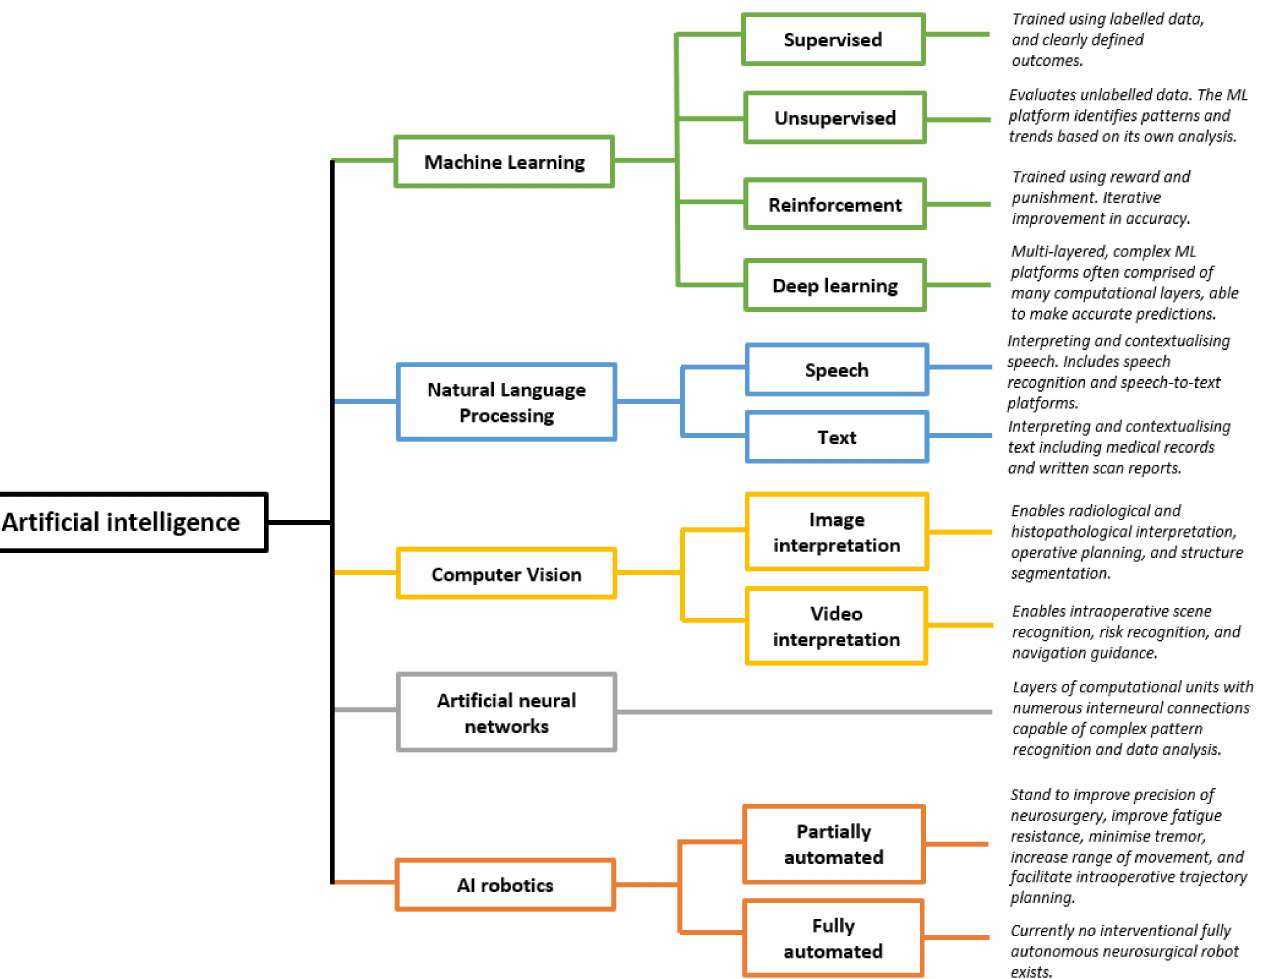
Figure 1. Artificial intelligence and five key subdomains. Each subdomain of AI has numerous potential clinical applications for brain tumour surgery patients. Schematic derived and modified from Panesar et al. [6] and Hashimoto et al. [9]. Numerous other subfields of AI exist, and this schematic is not exhaustive. Please add copyright if